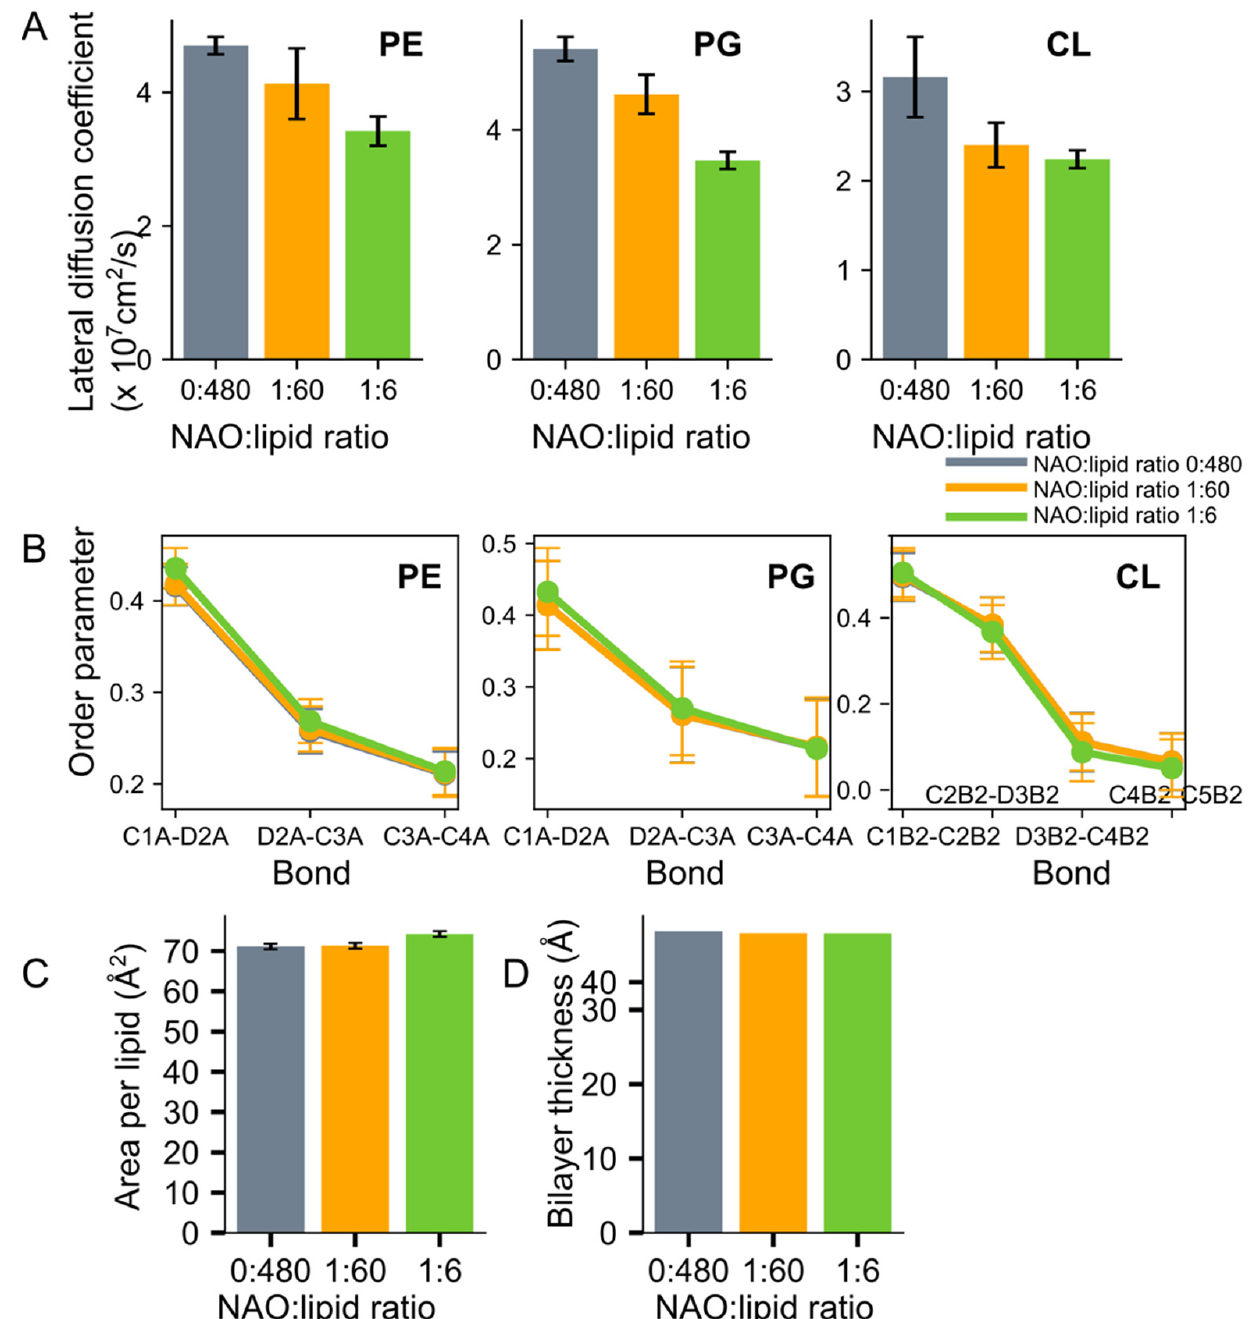
Figure 5. Lateral diffusion coefficients of lipids ( A ), order parameters of lipid acyl chains ( B ), area per lipid ( C ), and average bilayer thickness ( D ) of model membrane at different NAO concentrations. 2.3. Interaction of NAO with Lipids Lead to the Formation of Complexes with Different